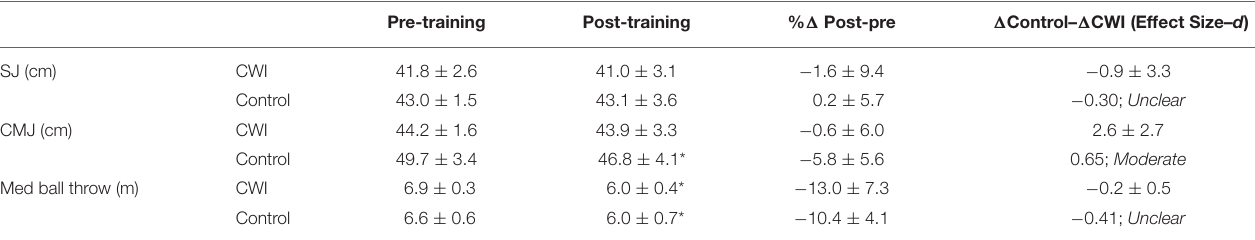
TABLE 2 | Mean ± SD of performance measures in the CWI and Control groups at different time points, and average of individual change (%) between pre- to post-training. Pre-training